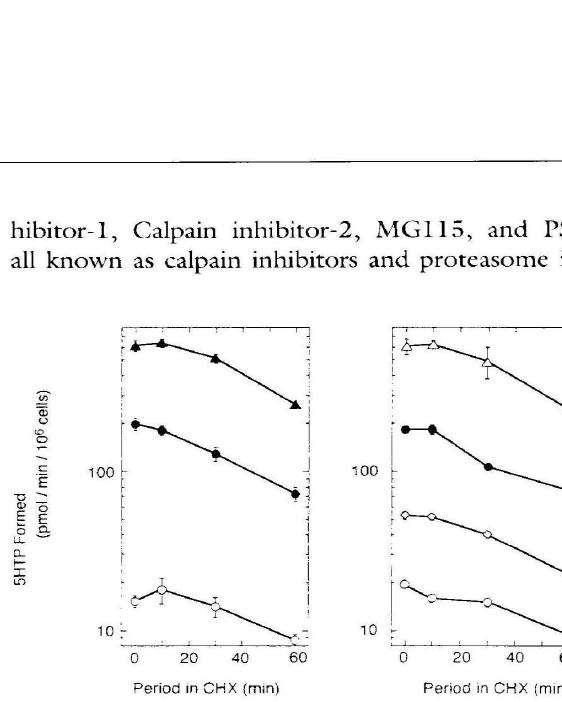
Figure 1. In vitro degradation of tryptophan hydroxylase: RBL2H3 cells (10' cells per well in a 96-well microassay plate) were placed in serum-free DMEM buffered with HepesjNaOH 2 hours prior to the experiment; then the cells were exposed to A23187 (0.1 J..LM) with or without calpain inhibitor for 6 hours, Right and left panels represent results of two independent experiments. Thereaft er they were placed in 10 J..Lg/ m1 of cycloheximide (CHX) for the indicated periods. Non-treated (open circle), treat ed with A23187 (closed circle), A23187 plus Calpain in hibitor-I at 1 J..LM (closed triangle; left panel) and at 10 J..LM (open diamond; right panel), and A23187 plus Cal pain inhibitor-2 (open triangle; right panel).